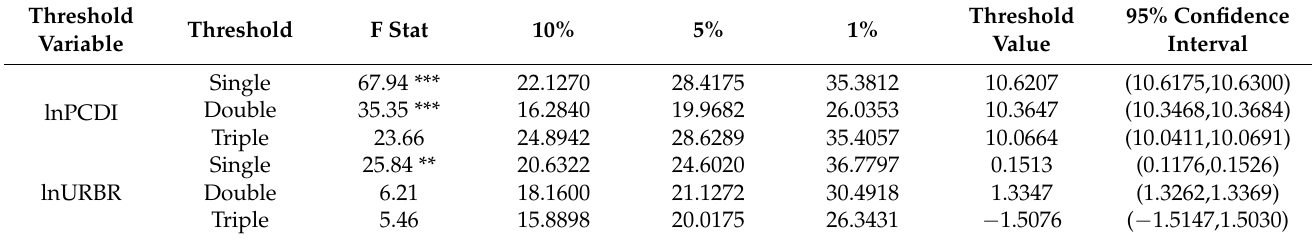
Table 4. Test of the threshold